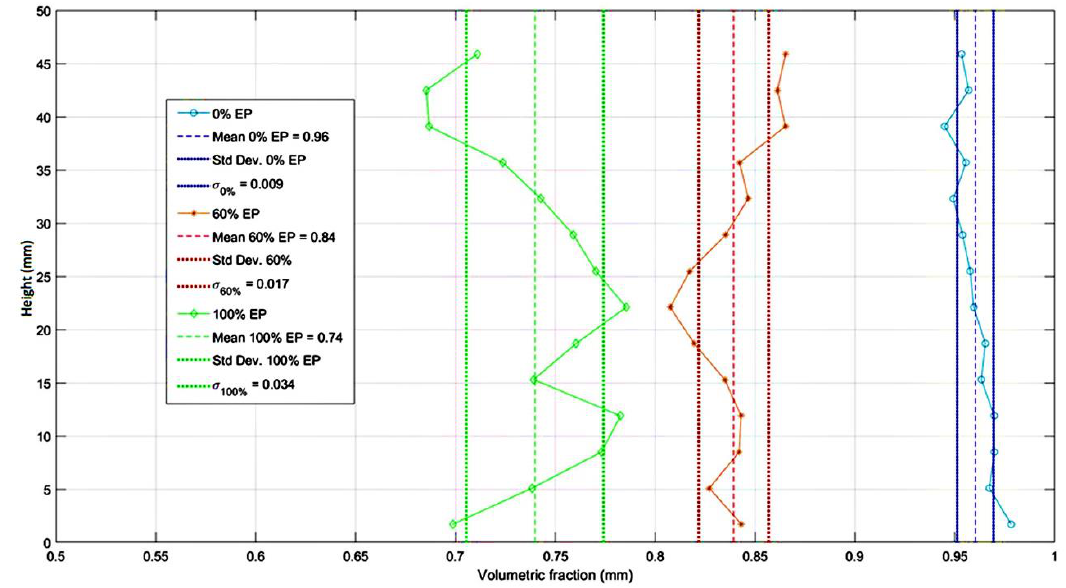
Figure 11. Volumetric fraction of paste throughout the sample’s height for mixtures 1, 4, and 6.